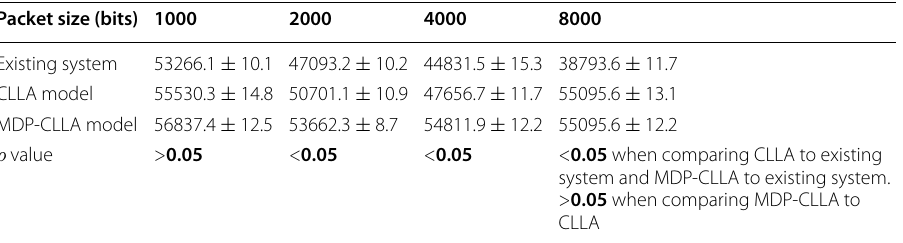
Table 12 Phase productivity results as mean SD Packet size (bits)